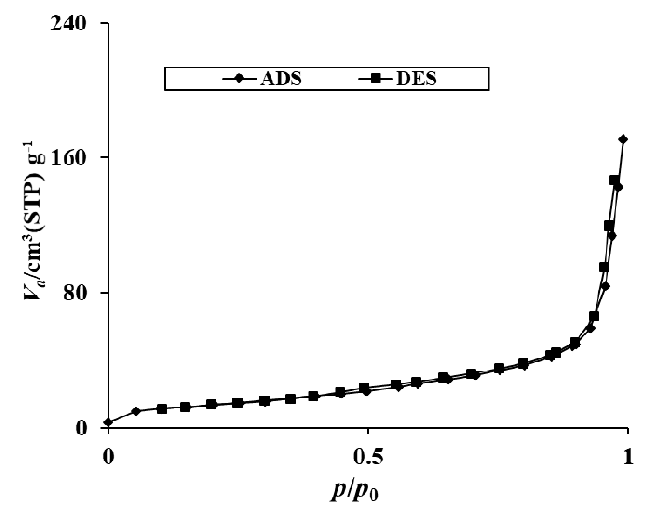
Figure 5. N 2 adsorption/desorption isotherms of the 20N–TiO 2 -300 photocatalyst.